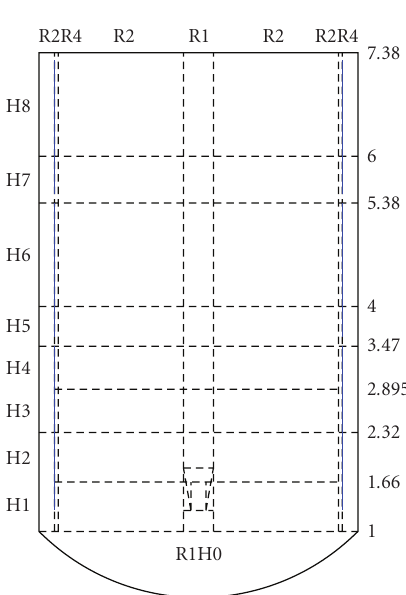
containment—11 structures. This nodalisation scheme was developed on the basis of the MISTRA facility nodalisation, which was used in the frame of ISP-47 [2]. In order to simulate the temperature and steam fraction gradients in more detail the previous nodalisation was refined. In the current nodalisation, there are four vertical subdivisions at the level of lower condenser instead of two in the previous ISP-47 nodalisation because the level of lower condenser corresponds to a region between 1 m and 4 m of the facility height and the gradients of both temperature and steam volume fraction are created in this region. Regions of middle and upper condensers were left subdivided into two vertical parts.